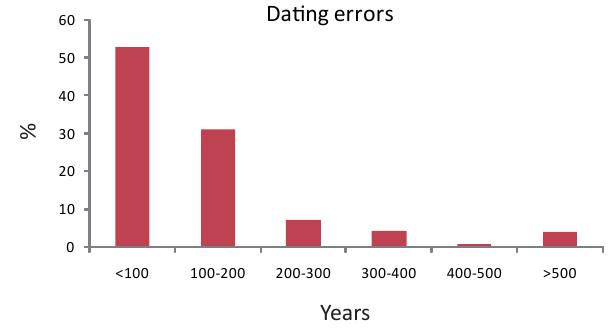
Fig. 2. The frequency distribution of the dating error in the collected proxies reported as 95% confidence intervals for the true ages of the proxy